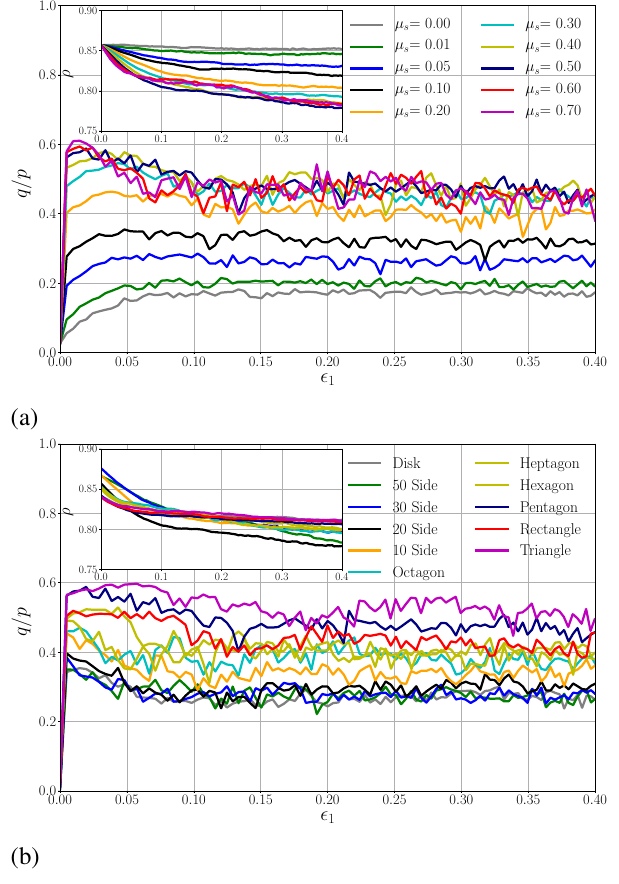
Figure 2. Stress ratio q / p and solid fraction ρ (inset) as functions of the vertical strain ε 1 . (a) Packings of pentagons for all values of the local friction µ s . (b) Packings with µ s = 0 . 5 for all shapes.